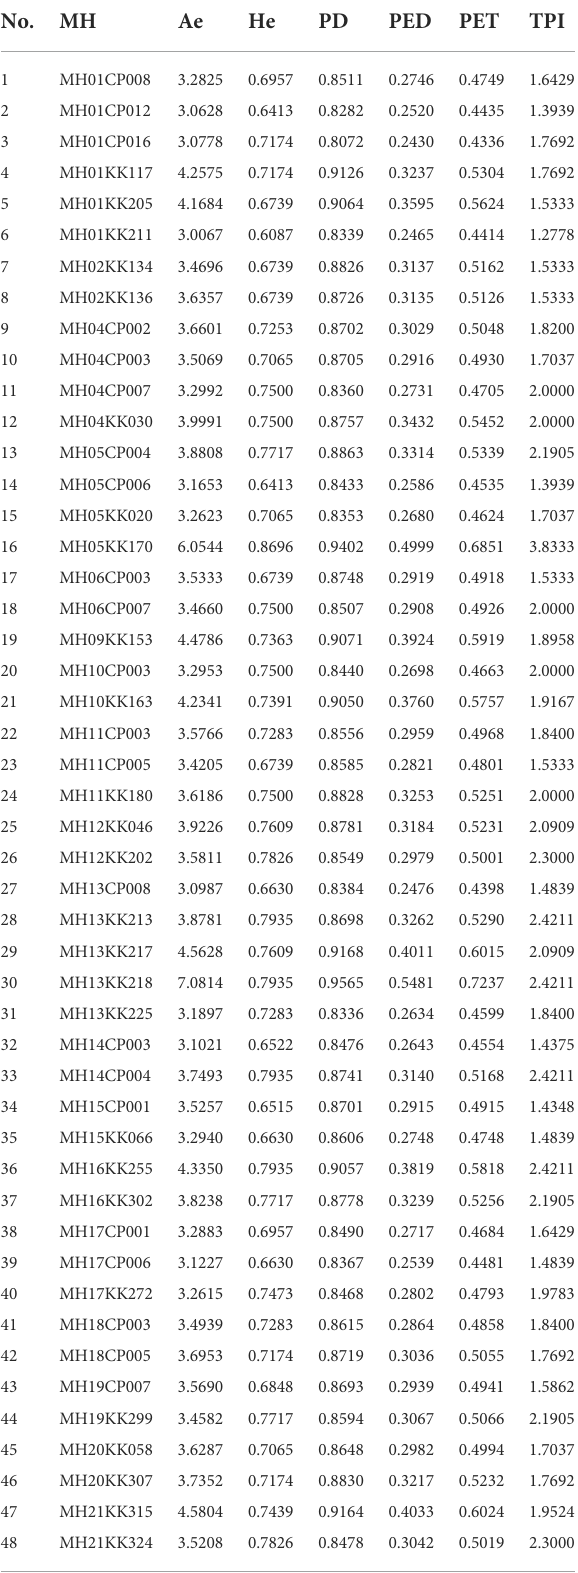
TABLE 1 Forensic parameters of 48 MH loci in the individual identi fi cation system. No.